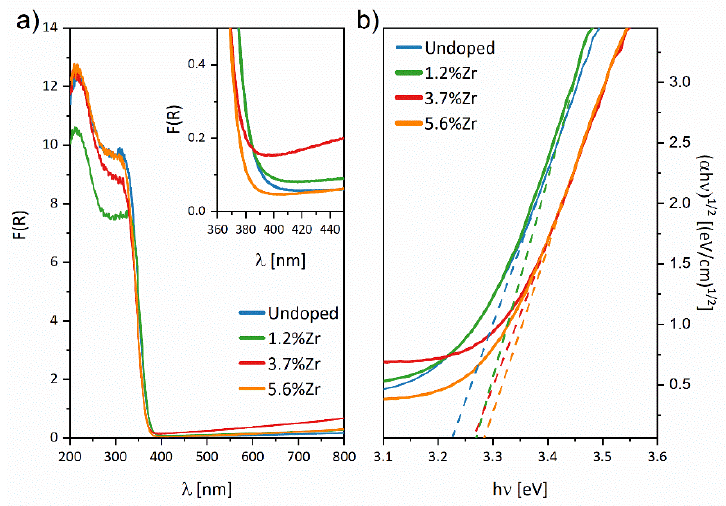
Figure 9. DRS spectra ( a ) calculated using the Kubelka–Munk function F(R), and indirect bandgap evaluation ( b ) for investigated samples.